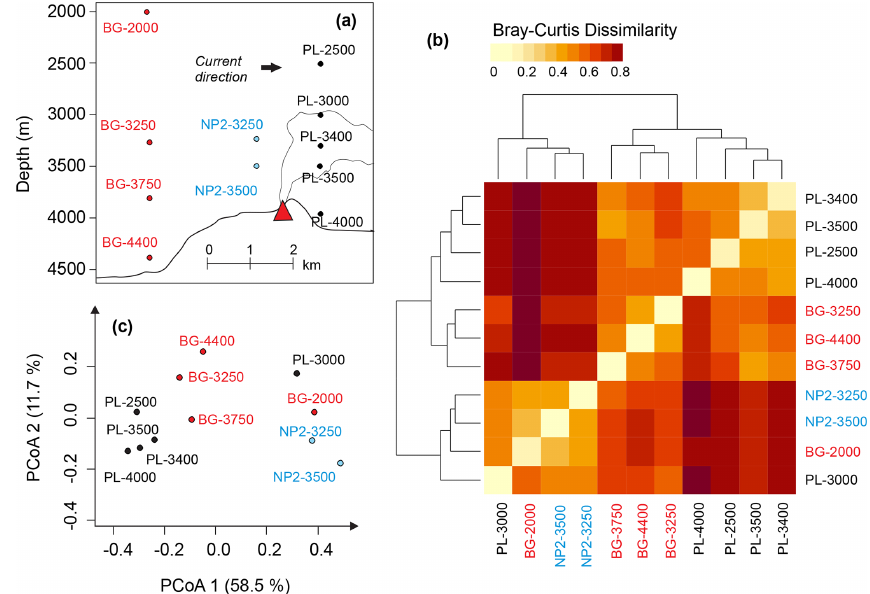
Figure 7. (a) Relative positions of the dissolved organic matter (DOM) samples below 2000m and the hydrothermal plume. (b) Heat-map representing the relation between hierarchical clustering of DOM compositions based on Bray–Curtis dissimilarity. (c) Principal coordi- nate analysis (PCoA) based on Bray–Curtis dissimilarity of DOM composition samples. Sample names are coded as station name and the approximate depth of the sample for background (BG), upper layer (UL), plume (PL) and non-plume (NP2)